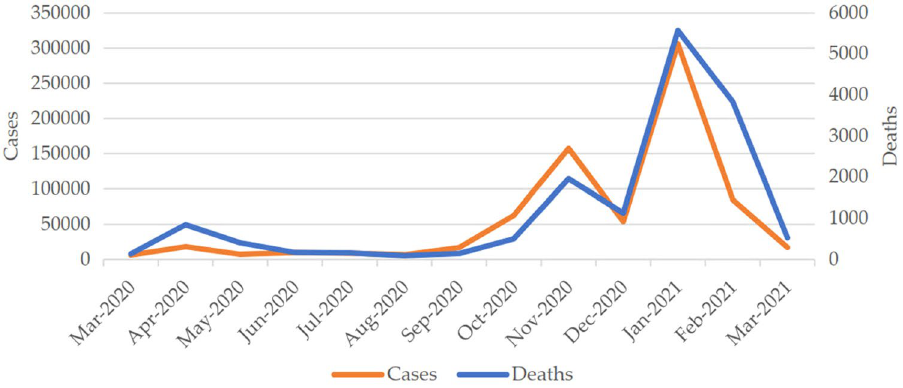
Figure 1. COVID-19 cases and deaths in Portugal, 1st—3rd waves. Source : 13 ,